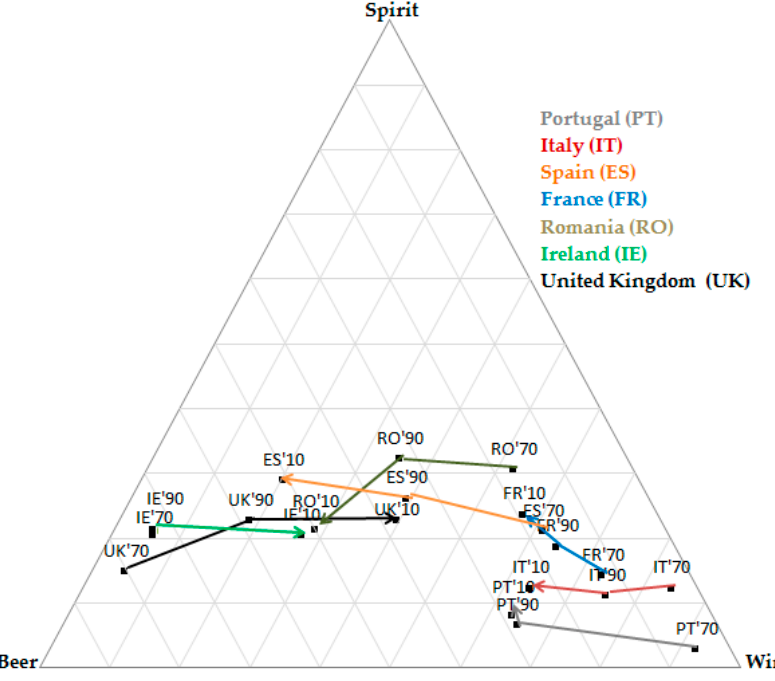
Figure 4. Dynamic development of a beverage-mix in the structure of European alcohol consumption.